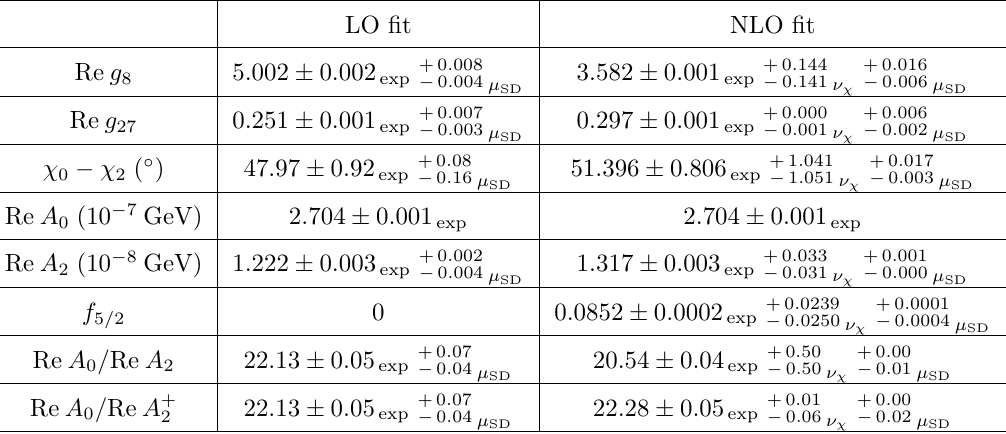
Table 8 . LO and NLO (cid:12)ts to the K ! (cid:25)(cid:25) amplitudes, including isospin breaking. scale (cid:22) (second errors). Our LO results are in agreement with the Flavianet averages SD